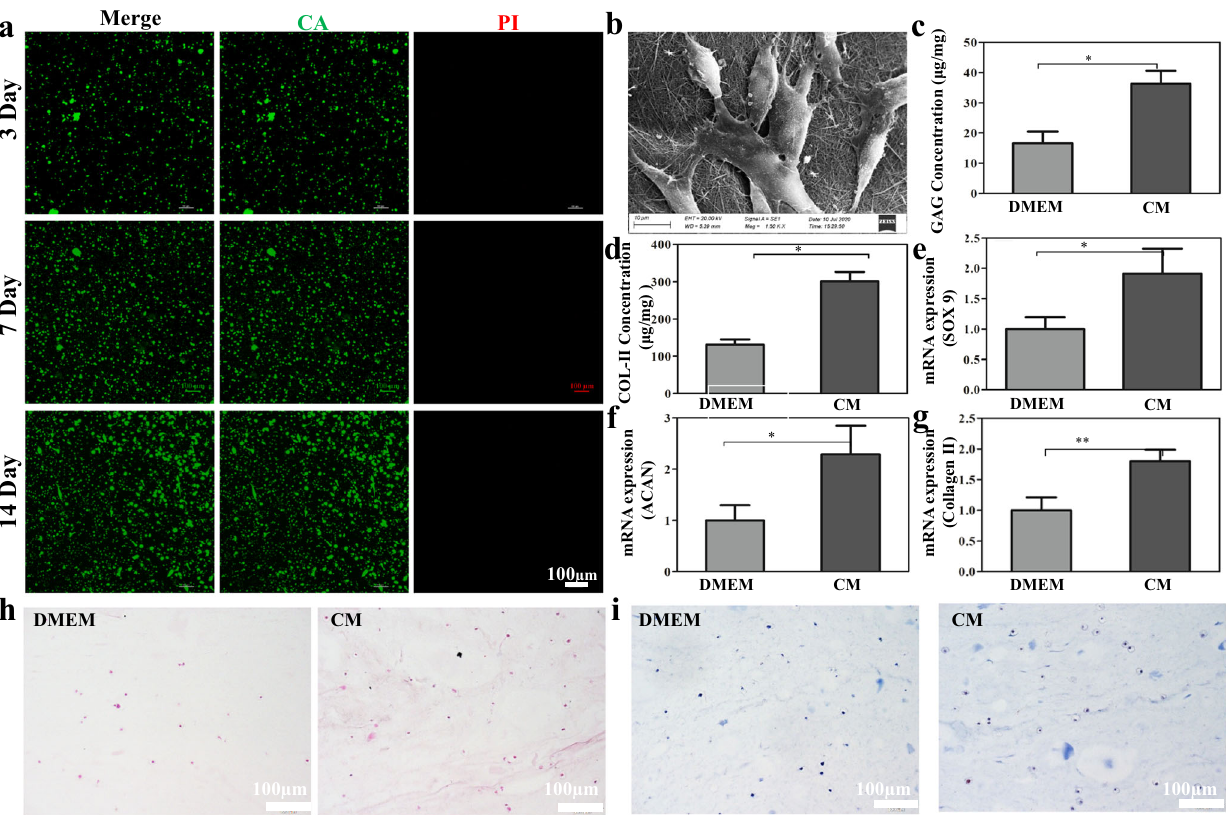
Fig. 4 Biocompatibility assay of the dECM hydrogels. a Live&Dead cell staining of the USCs in the dECM hydrogel. b Morphology of the USCs cultured in dECM hydrogels. Scale bar = 100 μ m. c , d The GAG and Collagen II (COL-II) concentrations of the USCs cultured in dECM with various mediums for 28 days. e – g Real-time PCR results of mRNA expression of SOX9, aggrecan (ACAN) and Collagen II in USCs cultured in dECM hydrogel with various mediums for 28 days. h , i H&E and Alcian blue staining was used to assessing the chondrogenic differentiation potential of the USCs cultured in the dECM hydrogel with various mediums for 28 days. DMEM (standard medium), CM (chondrogenic induction medium). Scale bar = 100 μ m. ns, not signi fi cant; * P < 0.05, ** P < 0.01, *** P < 0.001, * is the statistical difference compare with DMEM group. One-way ANOVA followed by the Tukey post hoc test was used. Each data point represents average ± standard deviation, n =